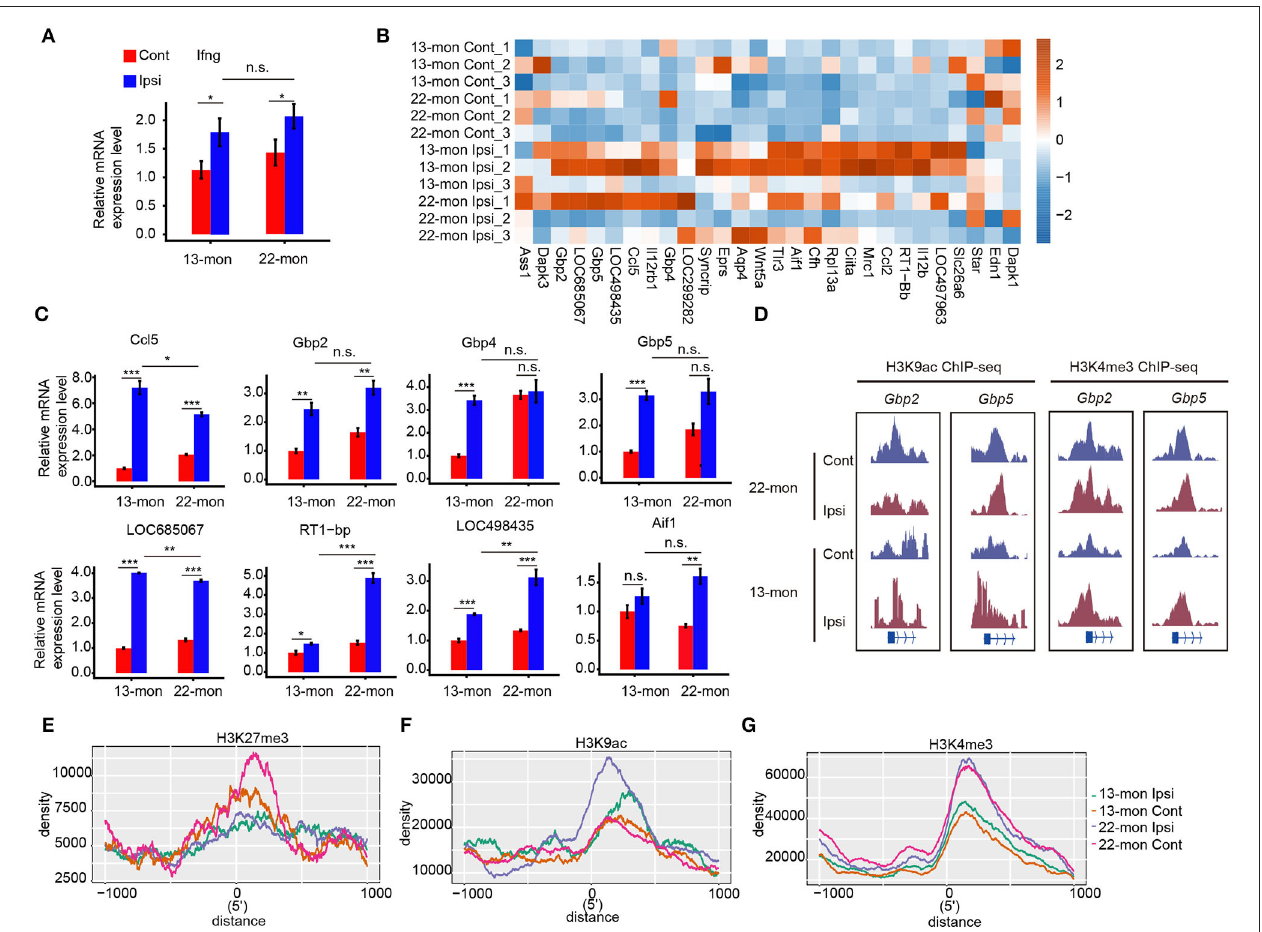
FIGURE 6 | IFN- γ pathway regulated by histone modification mediates acute brain injury in aging ICH rats. (A) Bar plot shows the increased expression level of Ifng in 13- and 22-month-old ICH rats 3 days after ICH surgery by RT-qPCR. (B) Heat map shows the upregulation of DEGs in response to IFN- γ after ICH surgery. Color bar indicates the normalized expression level. (C) Bar plot shows the increased expression level of genes (B) in 13- and 22-month-old ICH rats 3 days after ICH surgery by RT-qPCR analysis. (D) Read density plot shows the H3K9ac and H3K4me3 ChIP-seq signals on Gbp2 and Gbp5 , respectively. The signal height indicates the read density per million total mapped reads. (E–G) Line plot shows the histone mark density around the TSS region of genes in response to IFN- γ . Three histone marks are shown separately. The bar graphs show the mean ± SEM; p -value was determined by using the Student’s t-test. * p < 0.05, ** p < 0.01 and *** p < 0.001,